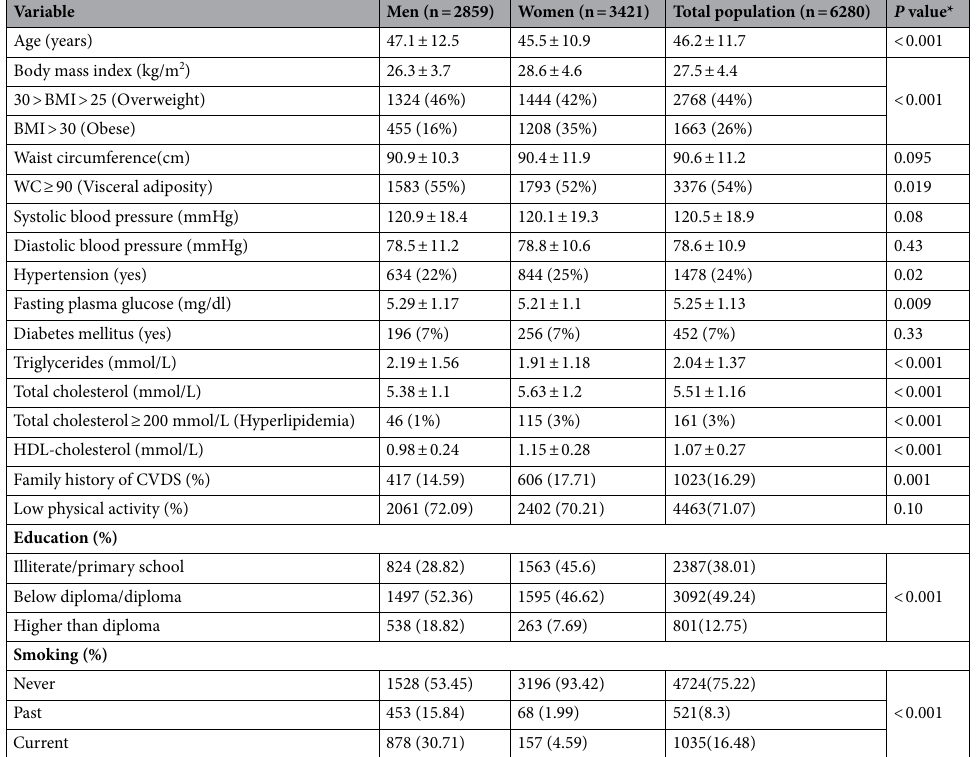
Table 1. Baseline characteristics of participants according to gender status, Tehran Lipid and Glucose Study (1999–2015). * Differences in continuous and categorical variables between males and females were assessed using the independent t -test and Chi-square test,